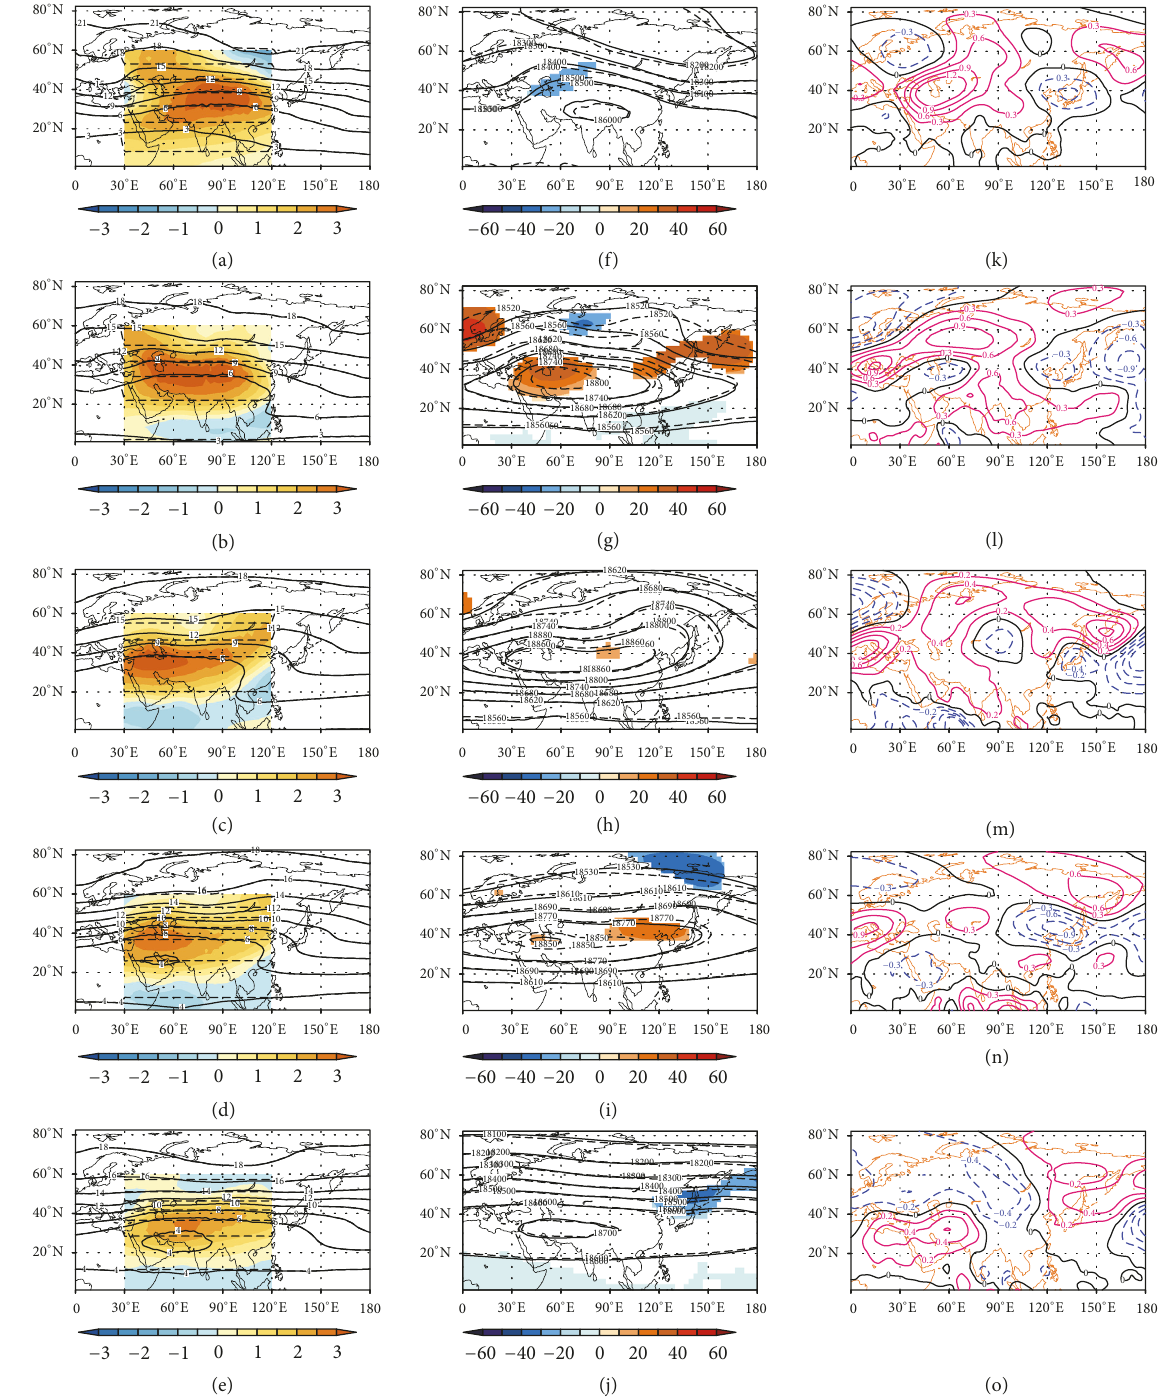
Figure 1: Ozone in CE (solid contour) and in SE (dashed contour) and difference of ozone between two experiments (SE − CE, shaded) at 70 hPa from May to September ((a–e), units: 10 −7 mol/mol); (f–j) same as (a–e) but for zonal deviation of geopotential height (units: gpm, valuesinshadedareaexceeding80%confidencelevel).Differenceoftemperaturezonaldeviationbetweentwoexperiments(SE − CE)at70 hPa from May to September ((k–o), units: